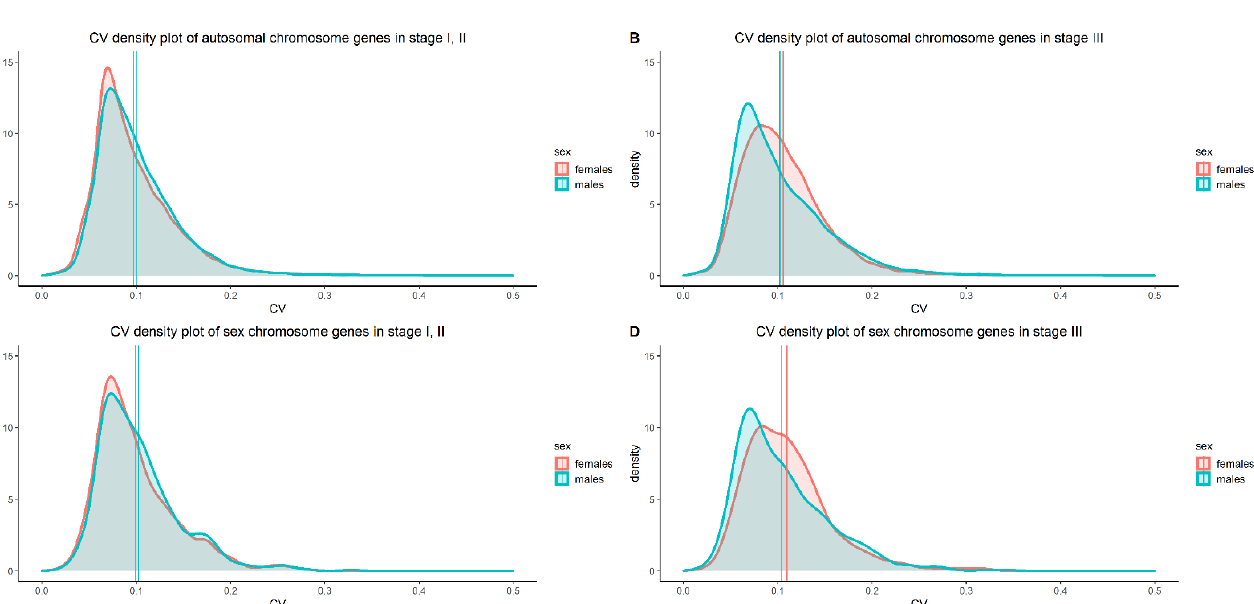
Figure 2. CV density plots, of the LMC gene expression data, on the sexes was created for: ( A ) autosomal chromosome genes in stage I, II; ( B ) autosomal chromosome genes in stage III; ( C ) sex chromosome genes in stage I, II, and ( D ) sex chromosome genes in stage III. The vertical lines on the x-axes represent the average CV of each sex for each analyzed subcategory. Table 4. Average coefficients of variation on the autosomal and sex chromosome genes of the melanoma (LMC, TCGA, GSE53118) and non-melanoma (Nevi, Normal skin) datasets were calculated for both females and males in the stratified stage groups. A Wilcoxon paired test between females and males was performed on the total number of genes included in every subcategory. The paired Wilcoxon test was also performed between stages I, II and stage III within the same sex on LMC and TCGA datasets. S-E = sun-exposed.